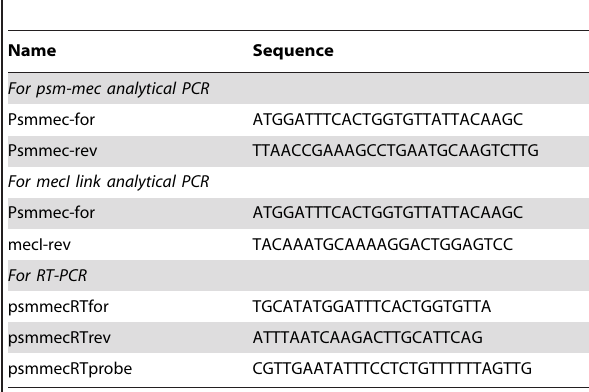
Table 2. Oligonucleotides used in this